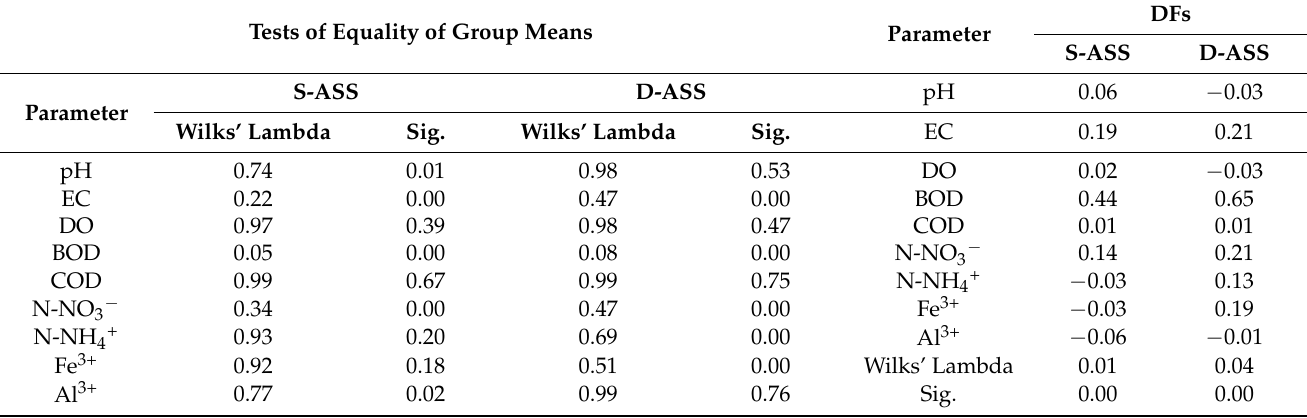
Table 2. The ability to discriminate ( a ) and the discriminant coefficient ( b ) of the temporal surface water quality variation of the land use patterns on the S-ASS and